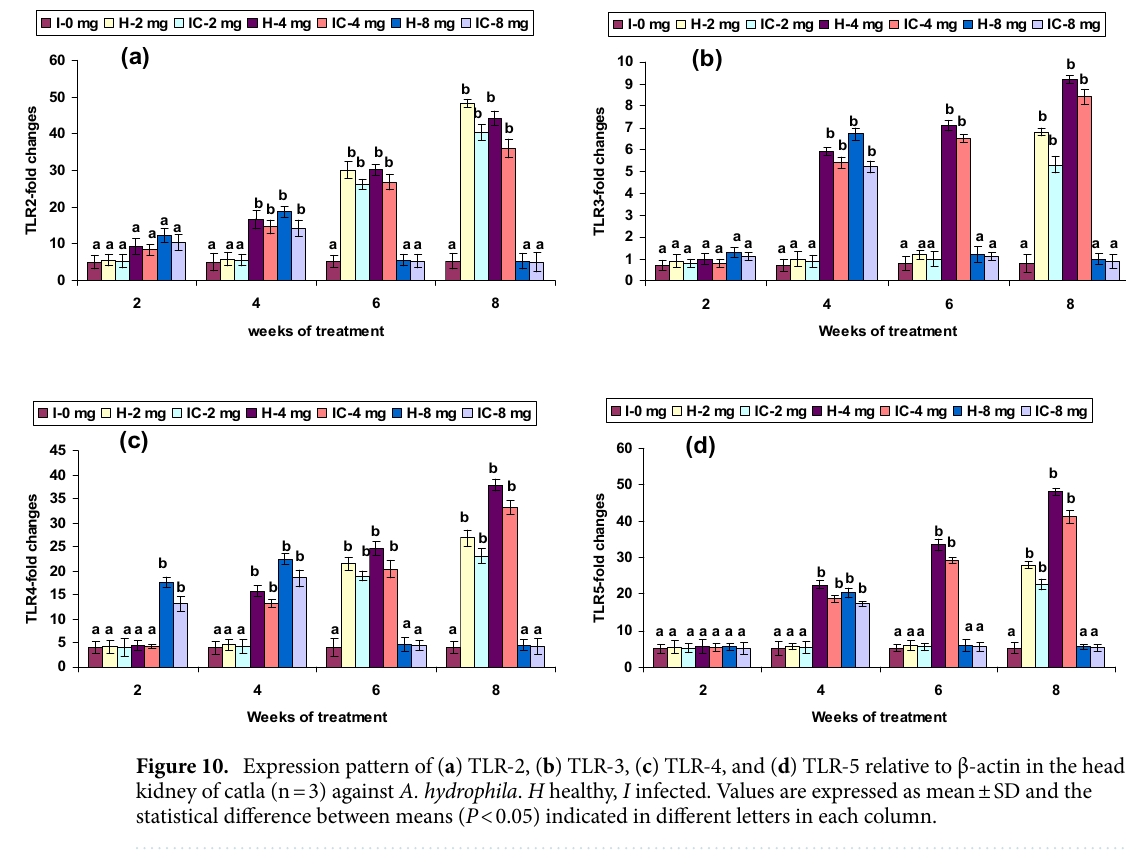
Figure 10. Expression pattern of ( a ) TLR-2, ( b ) TLR-3, ( c ) TLR-4, and ( d ) TLR-5 relative to β-actin in the head kidney of catla (n = 3) against A. hydrophila . H healthy, I infected. Values are expressed as mean ± SD and the statistical difference between means ( P < 0.05) indicated in different letters in each column.